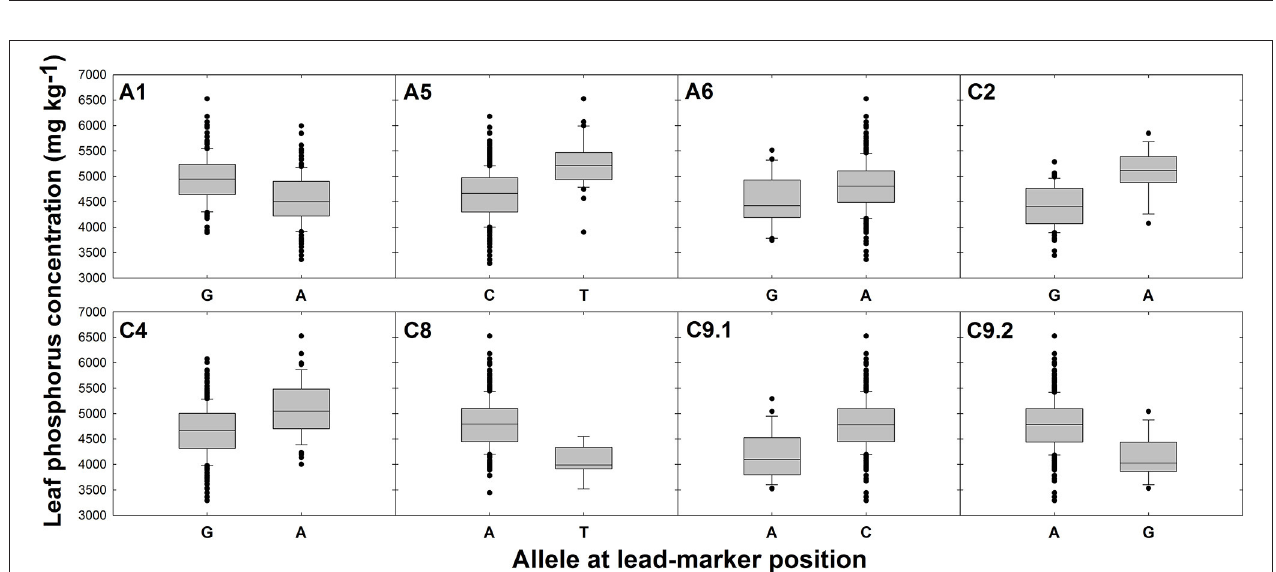
FIGURE 4 | Effects of reference allele and most frequent allelic variant at lead-marker loci on leaf phosphorus concentration. Each panel refers to a specific association peak; lead-markers at each peak are listed in table 1. Boxes represent the mid two quartiles with the median drawn; whiskers above and below the boxes indicate the 90 and 10th percentiles with any outliers shown. A, T, G, and C alleles represent adenine, thymine, guanine and cytosine nucleotide calls, respectively. Differences in leaf phosphorus concentration between alleles at each loci significant at p < 0.001 except locus on chromosome A6; p = 0.010.